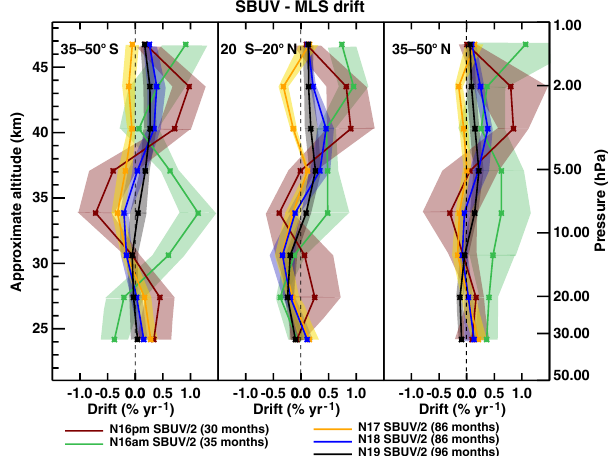
Figure 3. Drift of the NOAA SBUV instruments relative to Aura MLS over the time period of their overlap in %yr − 1 as a function of pressure level. Shaded areas indicate 2 σ uncertainties scaled to account for